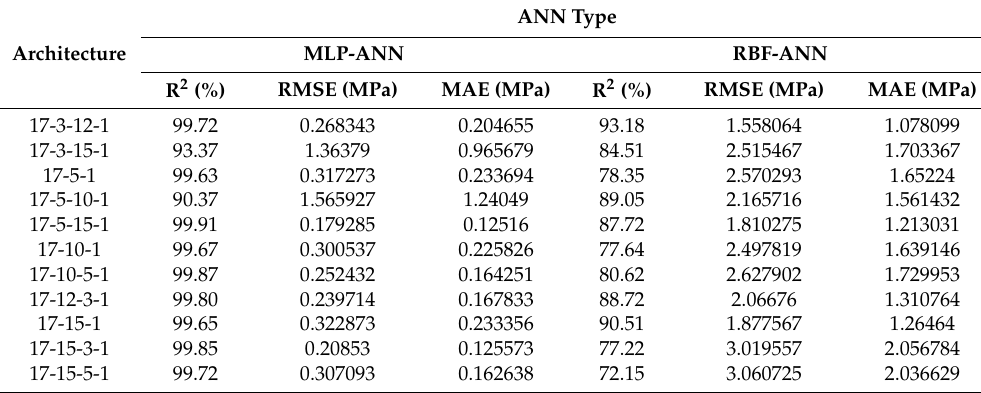
Table 4. Performance of different MLP and RBF ANNs in the prediction of the P i for the testing data series (Hoek–Brown case).